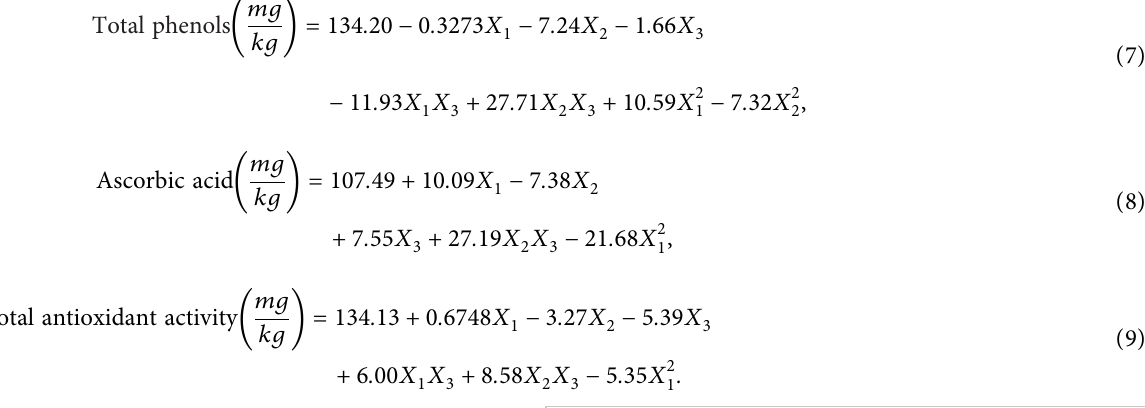
Supplementary Table 1: ANOVA table for reduced quadratic weight loss model of beeswax coating. Supplementary Ta- ble 2: ANOVA for reduced quadratic frmness model of beeswax coating. Supplementary Table 3: ANOVA for re- duced quadratic L ∗ value model of beeswax coating. Sup- plementary Table 4: ANOVA for a ∗ value reduced quadratic model for beeswax coating. Supplementary Table 5: ANOVA for reduced quadratic model of b ∗ value for beeswax coating. Supplementary Table 6: ANOVA for reduced quadratic model of total phenolic content for beeswax coating.